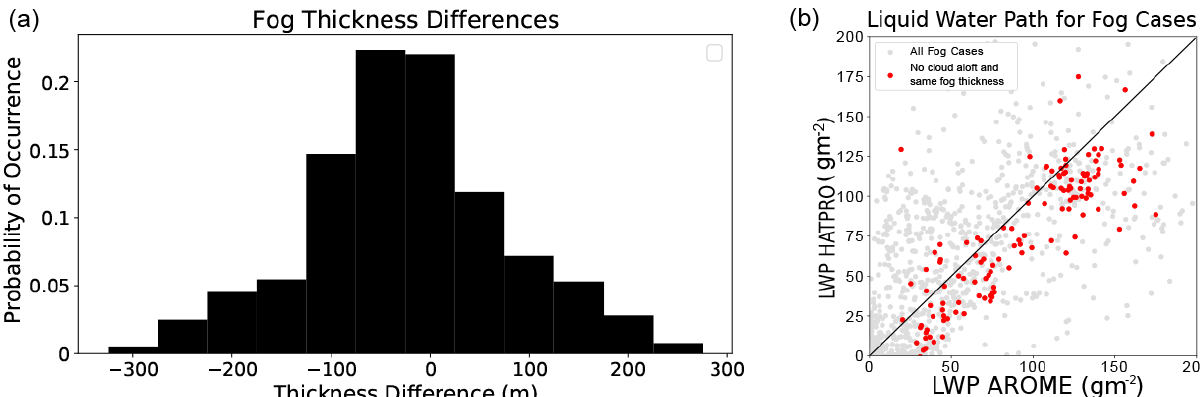
Figure 4. (a) Histogram of differences in the fog top height observed with the cloud radar and simulated by the AROME model (observation– simulation) when fog is both observed and simulated. Positive differences represent a larger observed fog thickness than is simulated. (b) Liquid water path recorded on the microwave radiometer and predicted in the AROME model for times at which both predict fog presence. All cases of fog in both the model and observations without restrictions are shown in grey. Red points show LWP values where the integrated cloud thickness above the fog layer does not exceed 25m (in either the model or observations) and the difference between the model and the observation fog top is less than